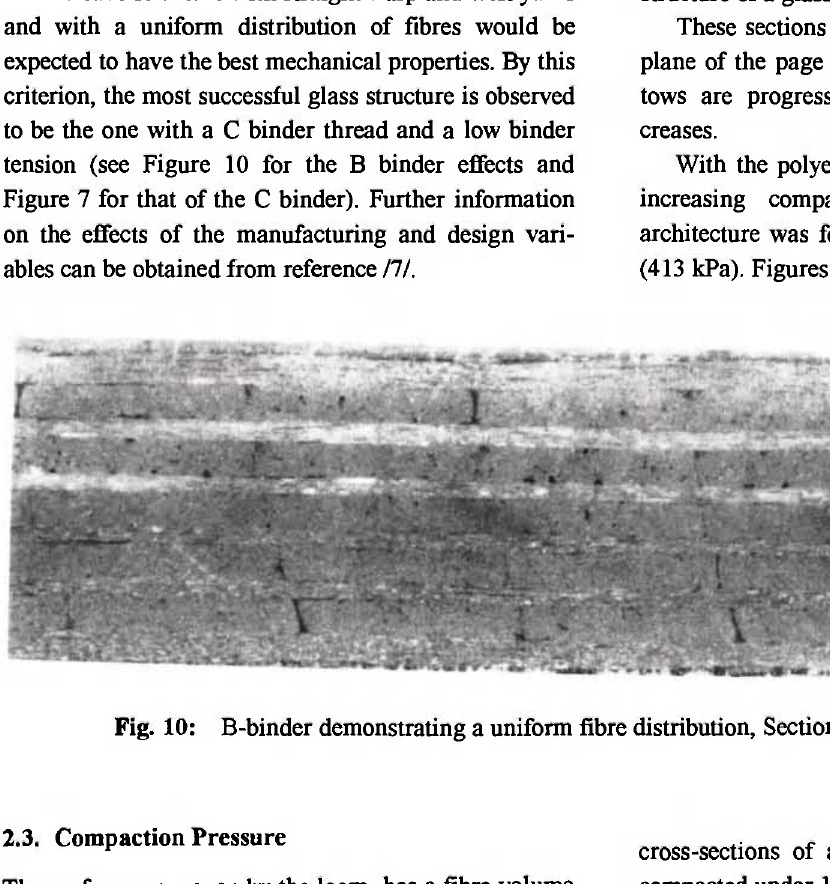
Fig. 9: B-binder, compressed (100 psi [689 kPa]), 11 layers glass. Section Y that the effect of weft tension upon preform architecture is far less for higher warp tensions.